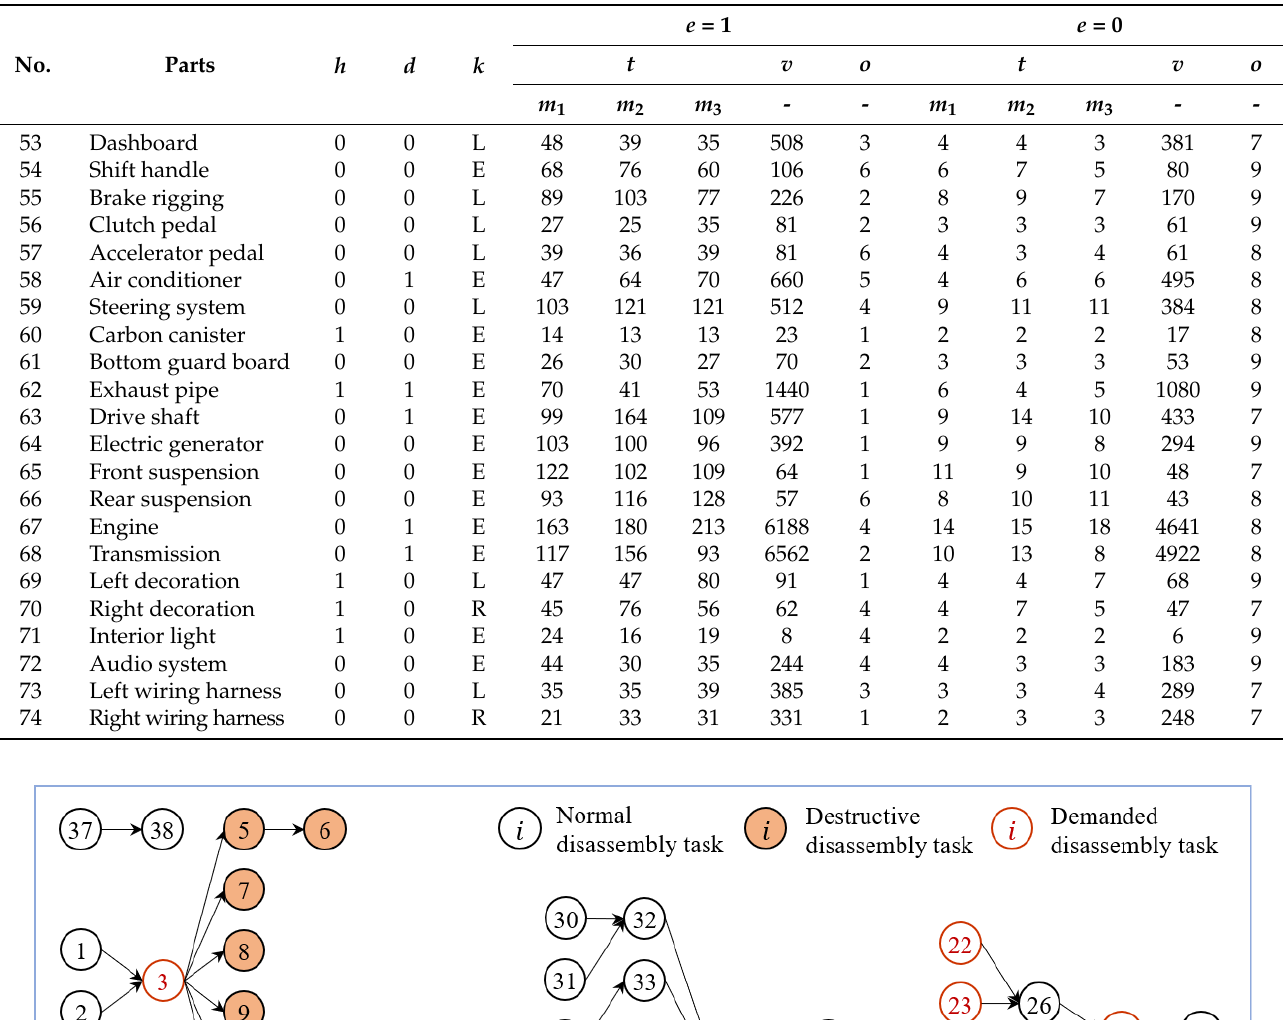
Table 3. Disassembly costs of different types of tools.